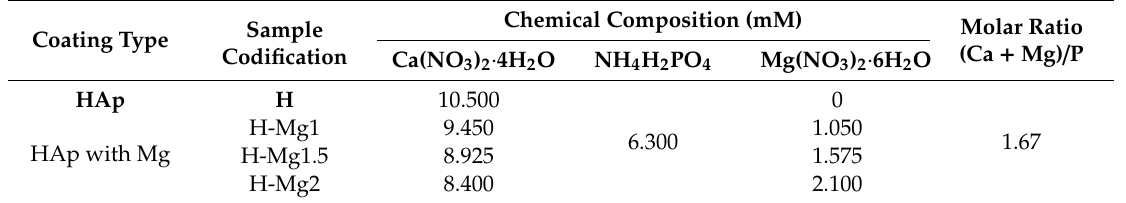
Table 1. Chemical composition of the used electrolytes and sample codification.